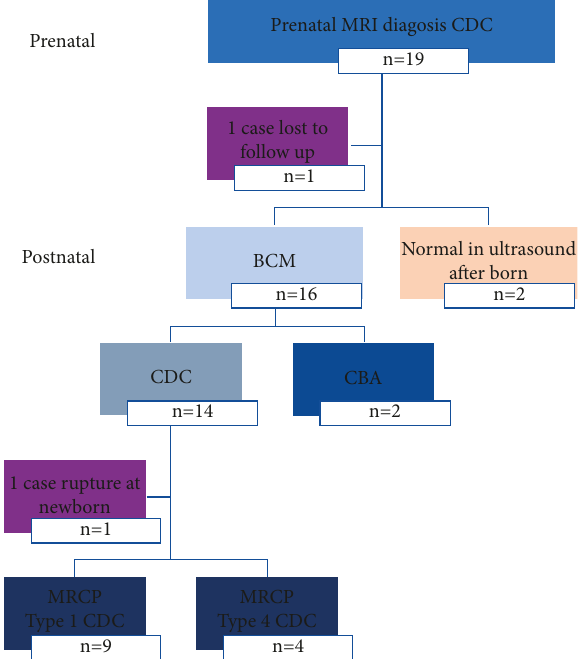
Figure 1: Study design and case